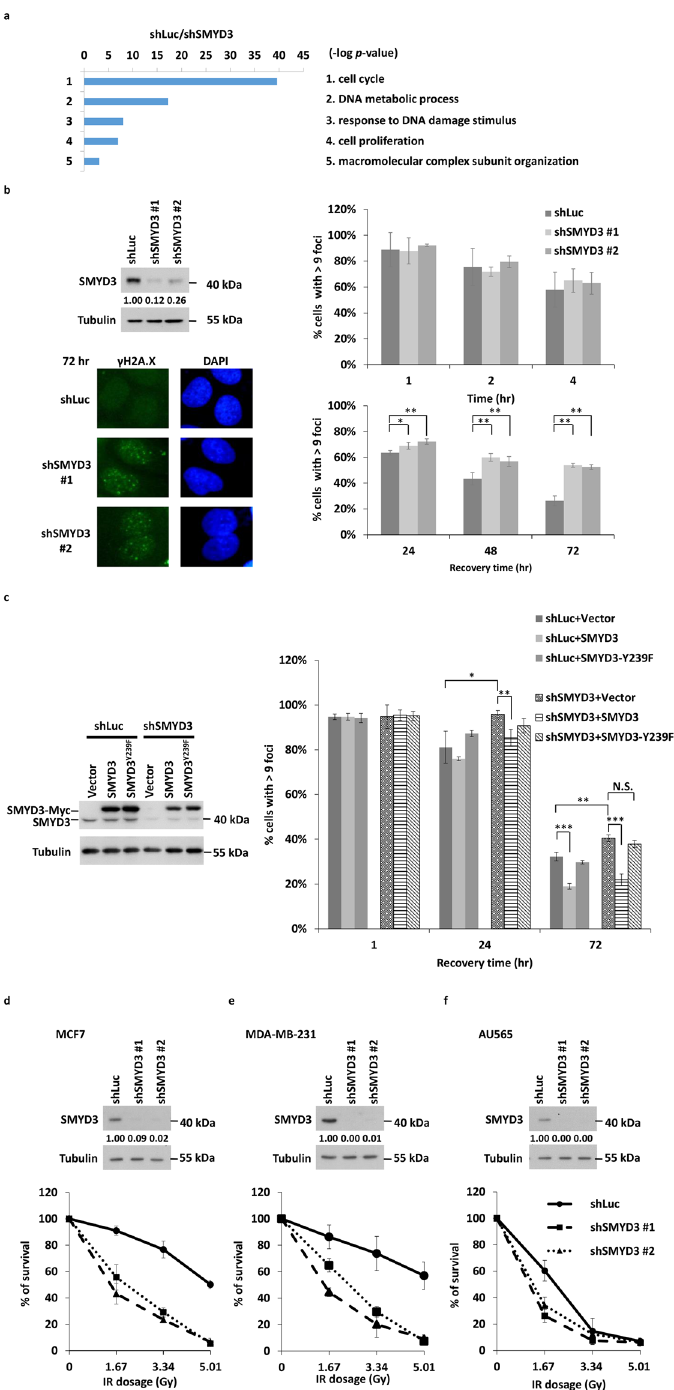
Figure 1. SMYD3 is required for DNA repair machinery. ( a ) Whole-genome microarray analysis of RNAs isolated from shLuc vs. shSMYD3 MCF7 cells was conducted. With a cut-off of absolute normalized fold change 0.5 (log2 normalized ratios < − 1), the list of down-regulated genes was further categorized by the DAVID v6.8 Gene Ontology program to reveal their gene ontology process. ( b ) γ H2A.X foci formation at indicated times after 1.67 Gy IR treatment in shLuc or shSMYD3 MCF7 cells. * P < 0.05. ** P < 0.01. ( c ) γ H2A.X foci formation at indicated times after 1.67 Gy IR treatment in shLuc or shSMYD3 MCF7 cells complemented with the vector control, SMYD3 or mutant SMYD3 Y239F . * P < 0.05. ** P < 0.01. *** P < 0.001. ( d – f ) Clonogenic survivals of shLuc and shSMYD3 MCF7 ( d ), MDA-MB-231 ( e ) and AU565 cells ( f ) treated with indicated dosages of IR. All values in the diagrams were means ± SD of triplicates and data were representative of n ≥ 3 for each